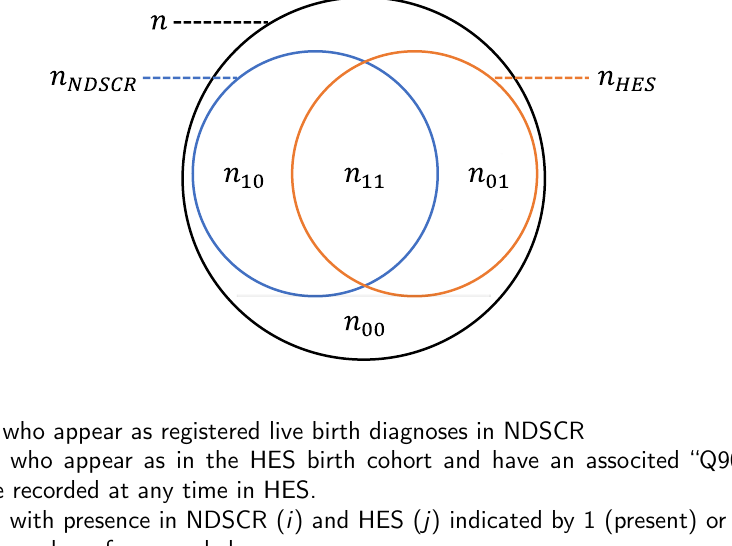
Figure 2: Subgroups for estimating prevalence and case